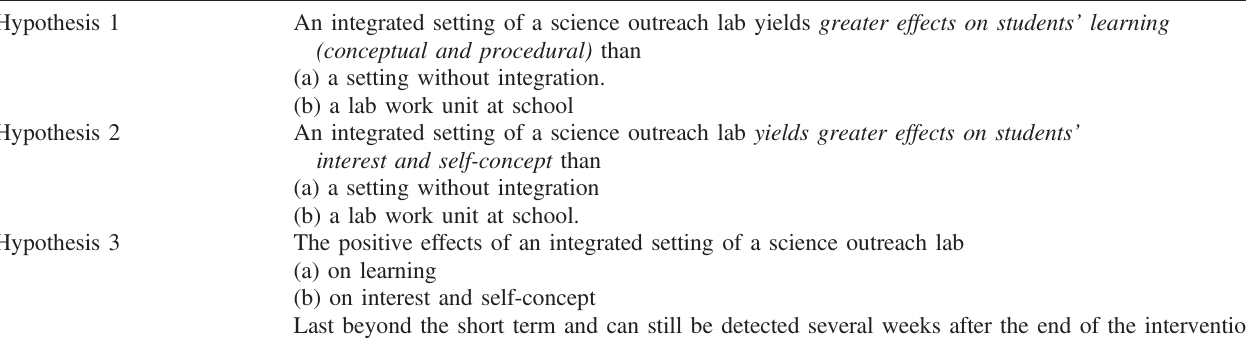
TABLE I. Research hypotheses. a